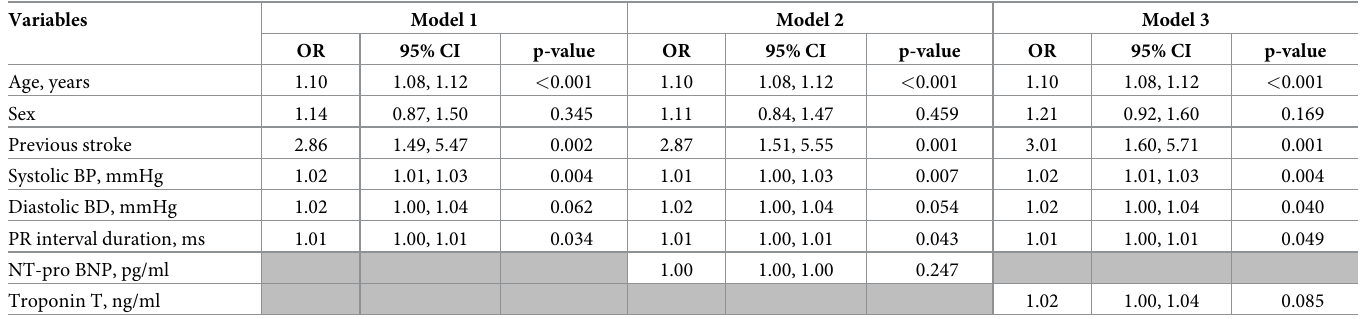
Table 3. Prediction of advanced WMLs (Fazekas stage 2–3), multivariable analysis.